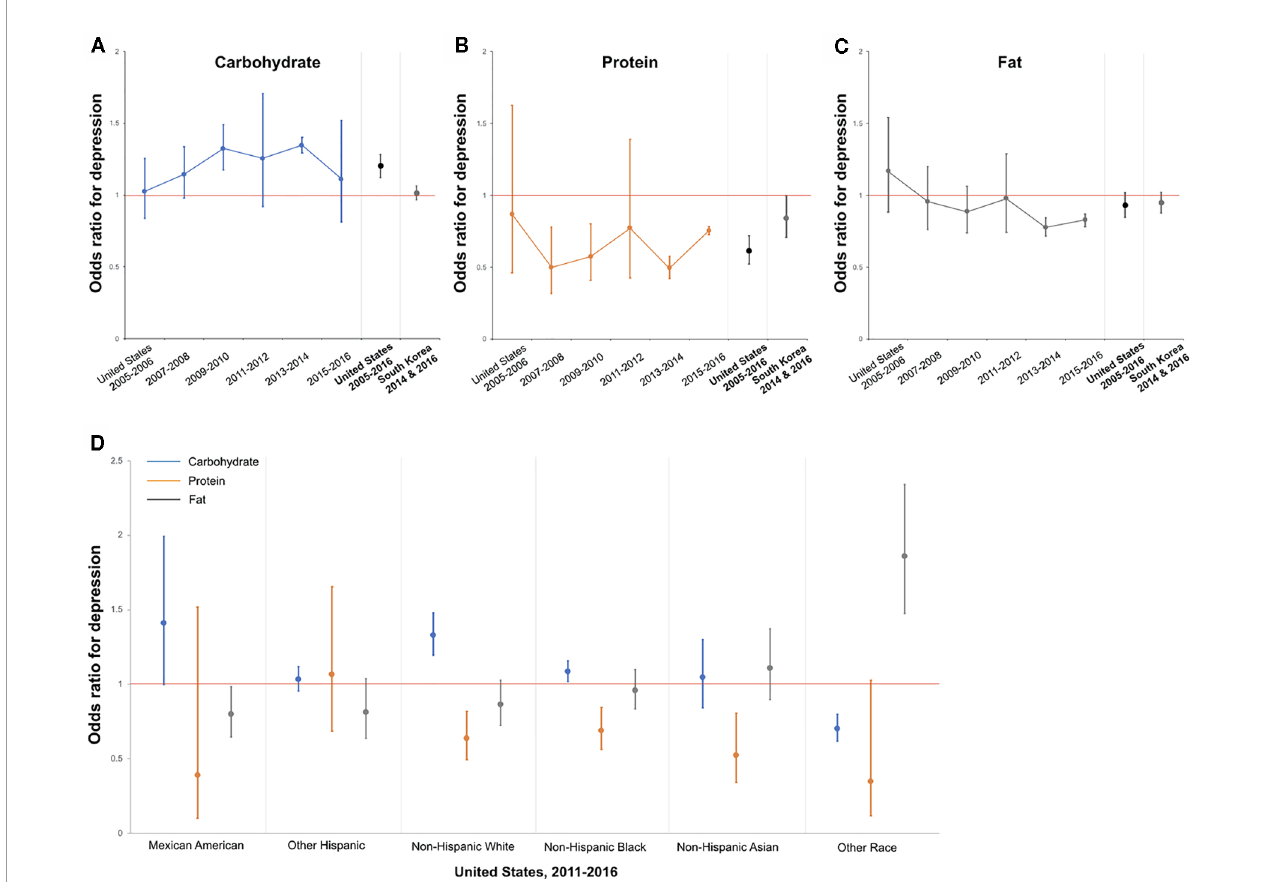
FIGURE 1 | Association between Protein Intake and Depression in the United States and South Korea — Trends based on 2-Year Datasets and Race Groups. (A) Odds ratio for depression as calories from carbohydrate increase by 10 percent. The results from 2-year datasets and pooled results of the United States and South Korea. (B) Protein. (C) Fat. (D) Odds ratio for depression as each macronutrient increase by 10 percent in each race/ethnic group. The results based on the pooled 2011 – 2016 NHANES datasets. Red line denotes an odds ratio of one. Error bars represent 95%